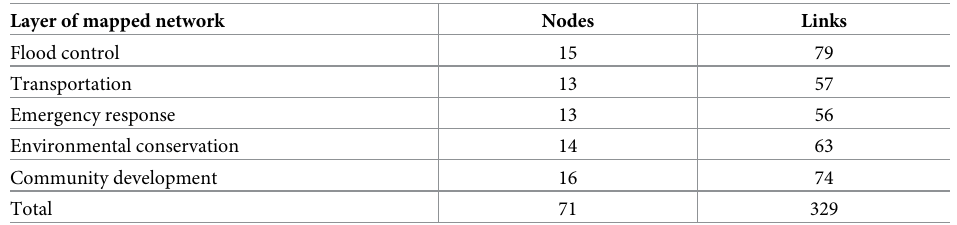
Table 3. Nodes and links in each layer of the mapped